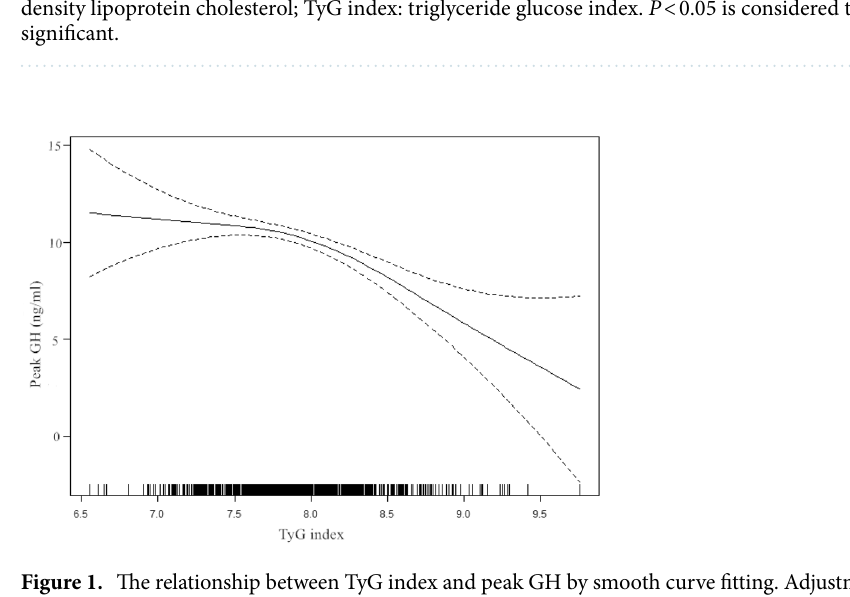
Figure 1. The relationship between TyG index and peak GH by smooth curve fitting. Adjustment variables: age, sex, BMI, TC, pubertal stage. BMI: body mass index, TC: total